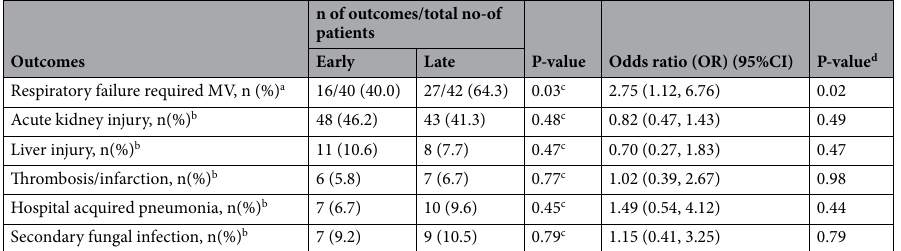
Table 1. Regression analysis of complications during ICU stay after propensity score. a Denominator of the percentage is non-mechanically ventilated patients with 24 h of ICU admission. b Denominator of the percentage is the total number of patients. c Chi-square test is used to calculate the P-value. d Propensity score matched used based on patient’s SOFA score, MV within 24 h of ICU admission, proning position, and early use of Tocilizumab within 24 h of ICU admission.